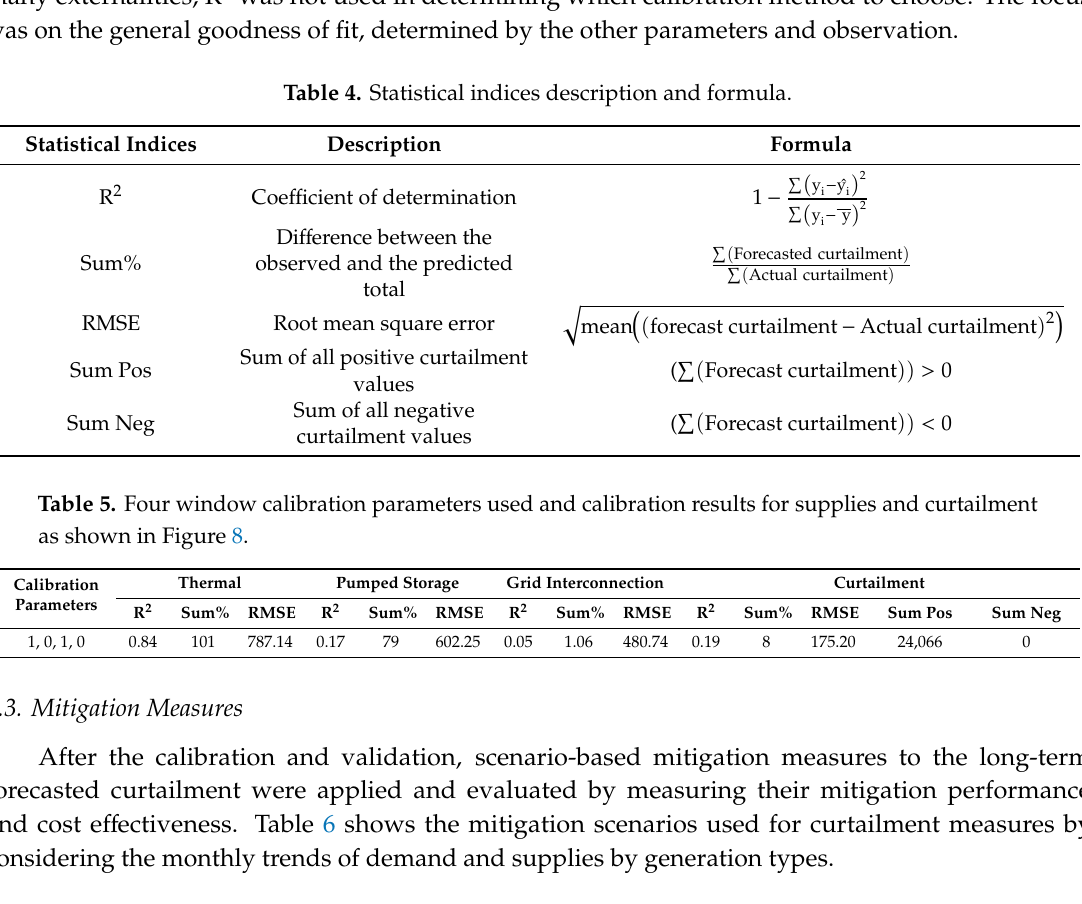
Table 6. Explanation of mitigation scenarios considered in this